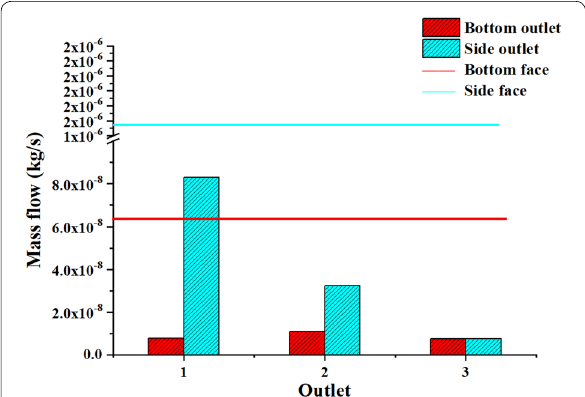
Figure 12 Mass flow in the outlets obtained using CFD simulation (the pore diameter is 434